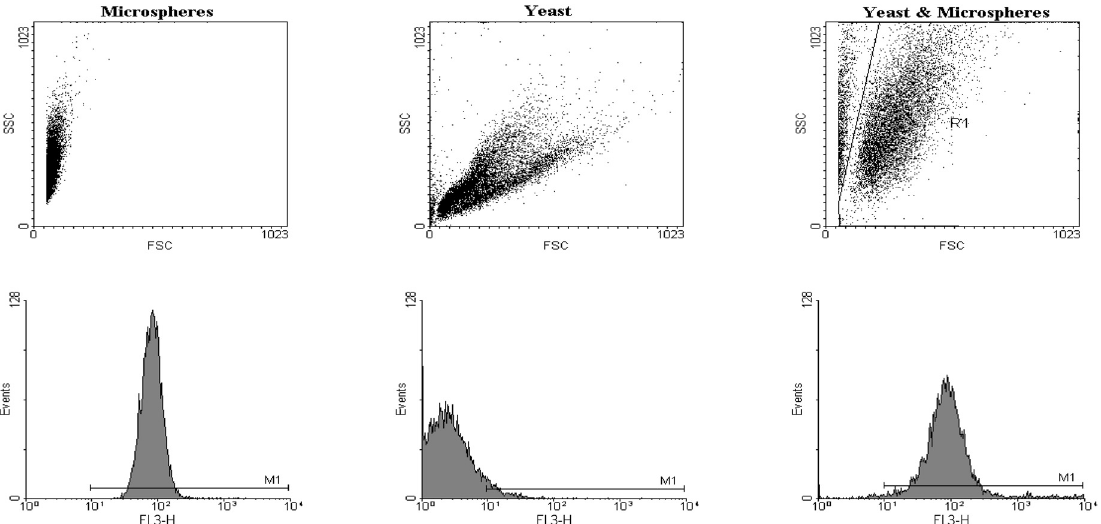
Figure 2. Flow cytometry is used to distinguish yeasts, dyed styrene microspheres, and yeasts to which styrene microspheres are bound. The geometry of the particles (yeasts or microspheres) is illustrated in the upper three panels. Microspheres showed a smaller forward scatter signal than yeasts. When yeasts that have interacted with microspheres are gated (polygon in upper right panel) they produce a strong FL3 signal (lower right panel) due to microsphere attachment. A marker (M1) is used to define fluorescent and non-fluorescent events. The relative fluorescence of each population is indicated by mean channel fluorescence, which is calculated from the histograms (lower